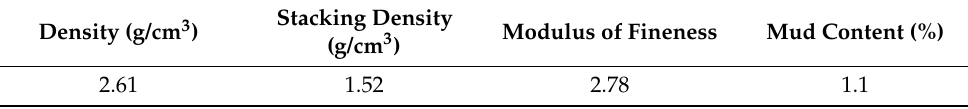
Table 3. Basic properties of the fine aggregate sand used in the